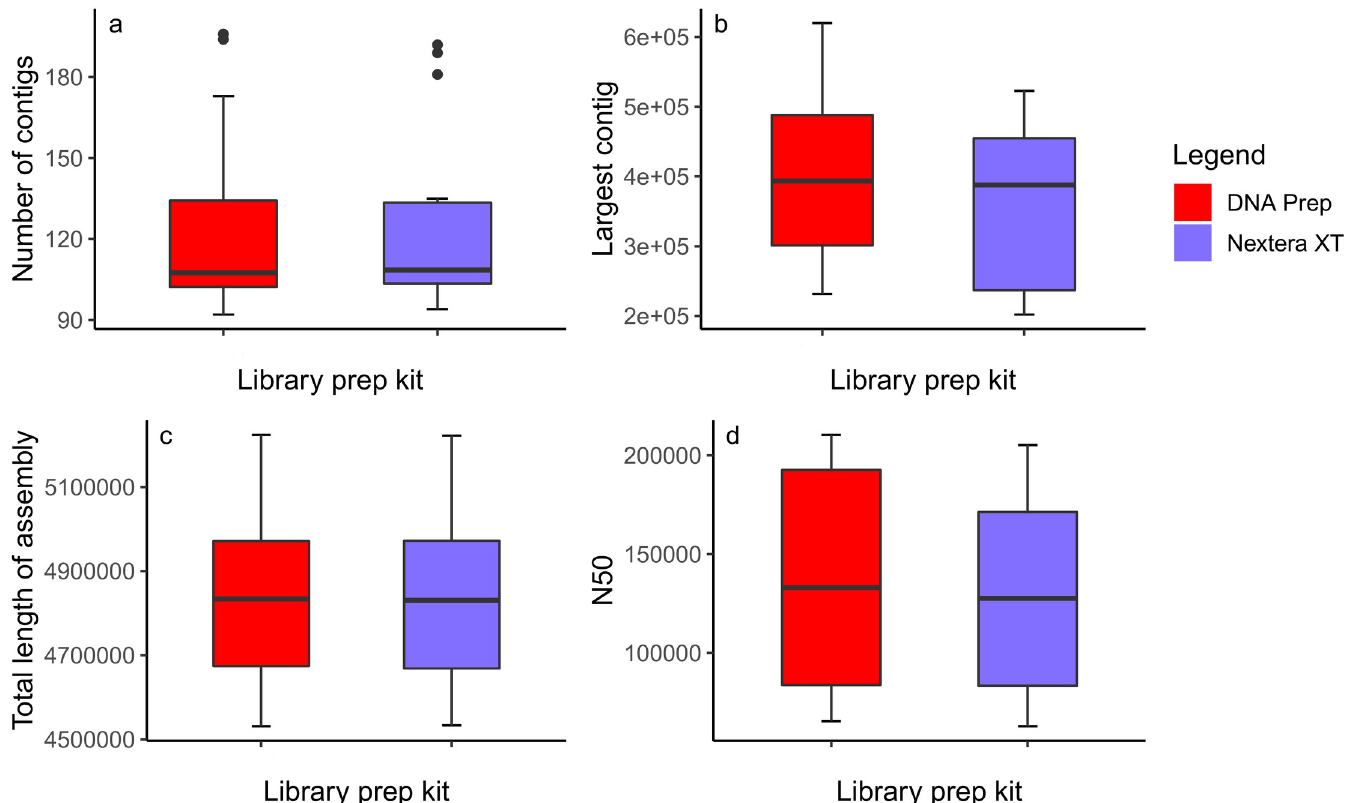
Fig 6. Comparison of de novo assembly quality between the two library preparation kits. (A-D) The difference in number of contigs per assembly (A), size of the largest contig in the assembly (B), total assembly length (C) and N50 based on which kit was used for library preparation.